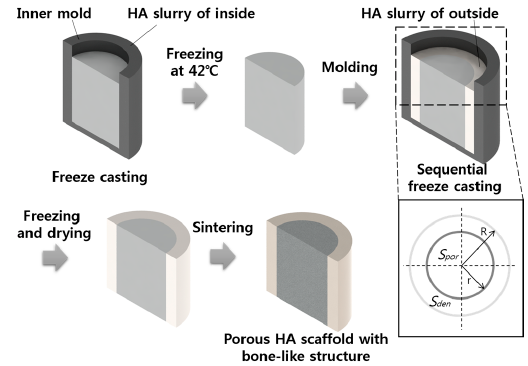
Figure 1. Schematic of the sequential freeze-casting process and the design of the bone-like structure (HA-hydroxyapatite; Spor -surface area of porous region; Sden -surface area of dense region; R-radius of the larger mold; r-radius of the smaller mold).